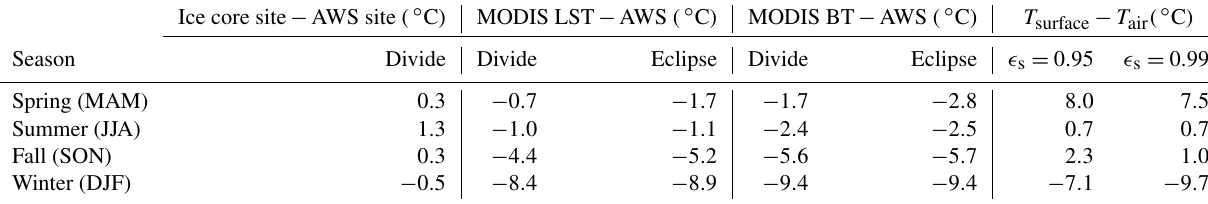
Table 2. Median differences between MODIS LSTs at the Divide ice core and AWS sites, median MODIS LST offsets by season at Divide and Eclipse, median MODIS brightness temperature (BT) offsets by season at Divide and Eclipse, and median calculated temperature inversions with surface emissivities of 0.95 and 0.99. Differences between MODIS LSTs at the ice core site and AWS site are reported as ice core site − AWS site ( ◦ C). All offsets are reported as MODIS − AWS ( ◦ C). Brightness temperatures for bands 31 and 32 are averaged together. Inversions are reported as negative values.